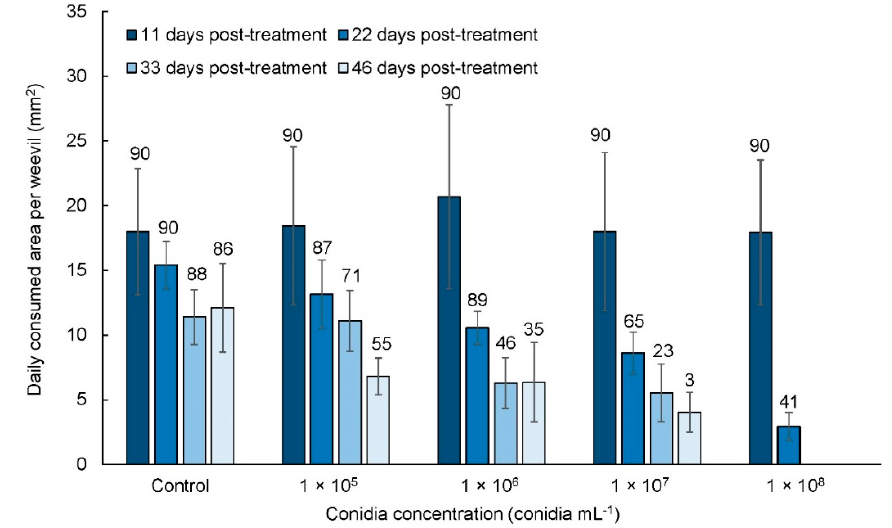
Figure 4. Mean daily damaged area (mm 2 ) of bark on twigs by Hylobius abietis adults after their inoculation with different conidia suspensions of Beauveria bassiana strain AMEP20. Values above bars represent numbers of surviving H. abietis adults on specific days post-treatment.